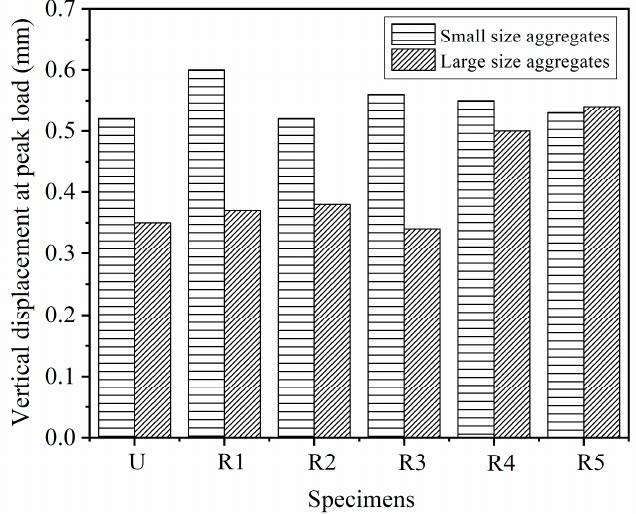
Figure 14. Vertical displacement at peak load of geogrid-reinforced beam.